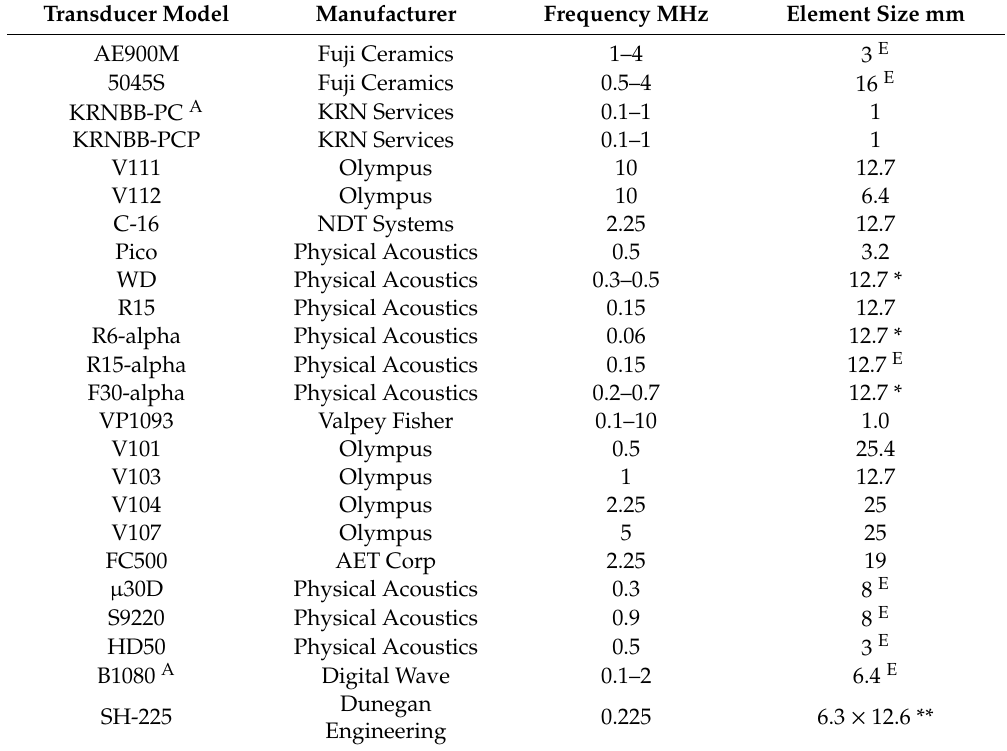
Figure 9. Rayleigh waves (RW) receiving sensitivities of the two KRN sensors in solid curves. Corresponding dotted curves show NW receiving sensitivities. KRNBB-PC in red and KRNBB-PCP in blue. Table 1. Transducers and sensors used.